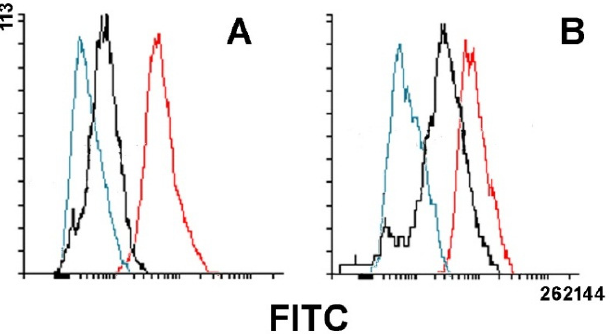
Figure 5. Representative plots showing the accumulation of ROS in gated alive MDA-MB231 cells treated with crude extracts (( A ); 9.16 µ g / mL) and 10K fractions (( B ); 8.34 µ g / mL) for 48 h (black peaks). The blue peaks correspond to the untreated cell preparations. The orange peaks originate from preparations of cells exposed to H 2 O 2 and therefore over-producing ROS. The x -axis reports the intensity of green fluorescence emitted by the dye 2’,7’-dichlorodihydrofluorescein, which is proportional to the amount of intracellular ROS.